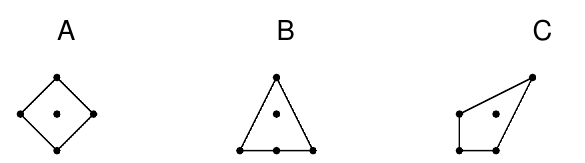
Figure 5 . Three toric diagrams which have pure SU(2) gauge theory description along certain locus of Coulomb